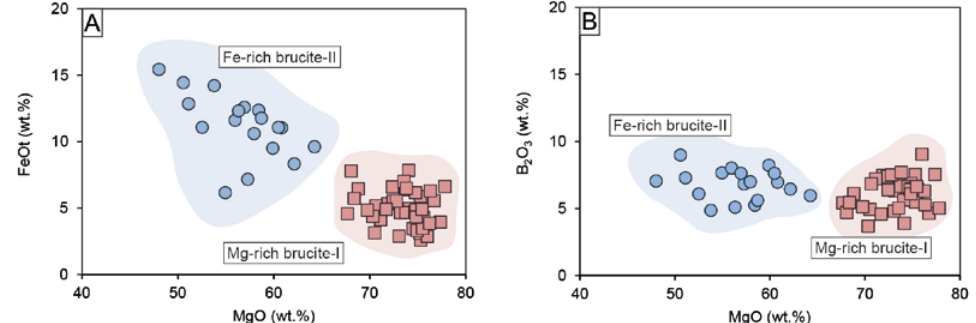
Figure 8. Binary plots of brucites showing the different compositions of brucite-I (red highlighted)